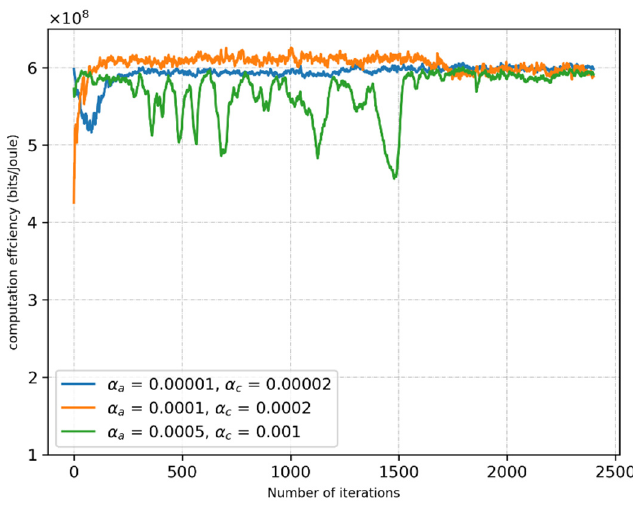
Figure 3. Convergence performance of the DCMCE algorithm under different learning rates.